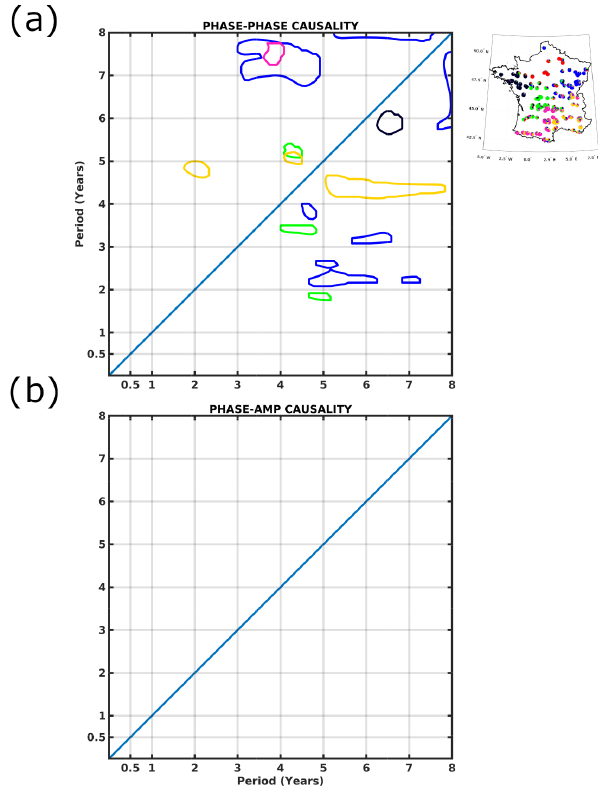
Figure 12. Discharge cross-scale interactions (95% significance level). The driving timescale is on the horizontal axis and the driven on the vertical axis (i.e., the timescale x phase has a causal relation- ship with the phase/amplitude of the driven timescale y ). Lower (up- per) half of the graph, below (above) the diagonal, shows timescales acting on smaller (larger) timescales. (a) Phase–phase causality. (b) Phase–amplitude